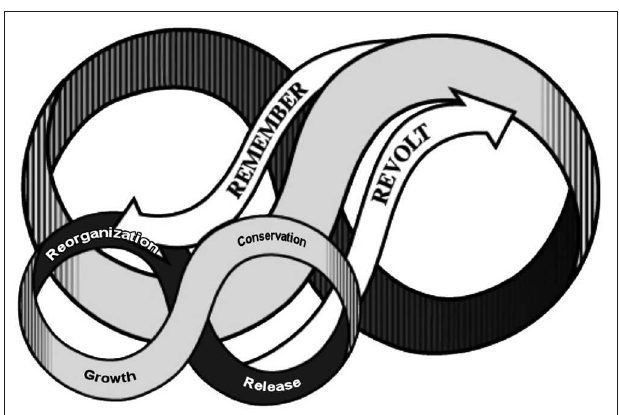
FIGURE 1 | Adaptive cycle and panarchy (adapted from Nelson and Stroink, 2019; based on Gunderson and Holling, 2001).